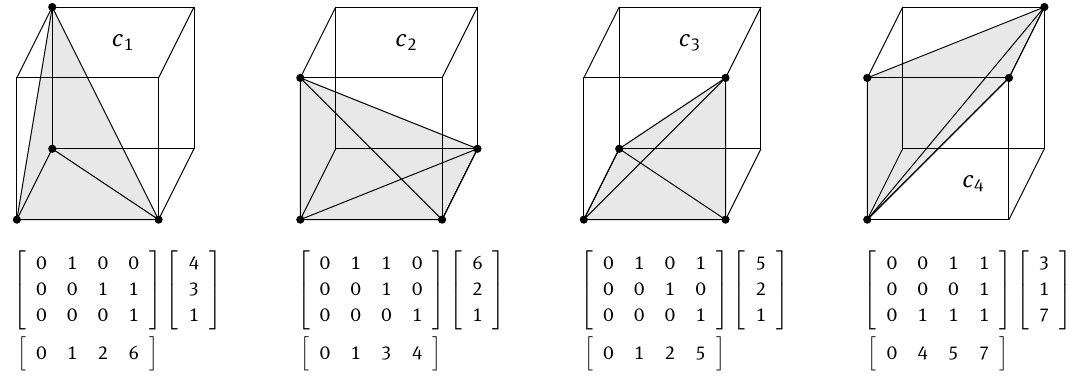
Figure 10: Four 0/1 -equivalent 0/1 -tetrahedra with corresponding matrix